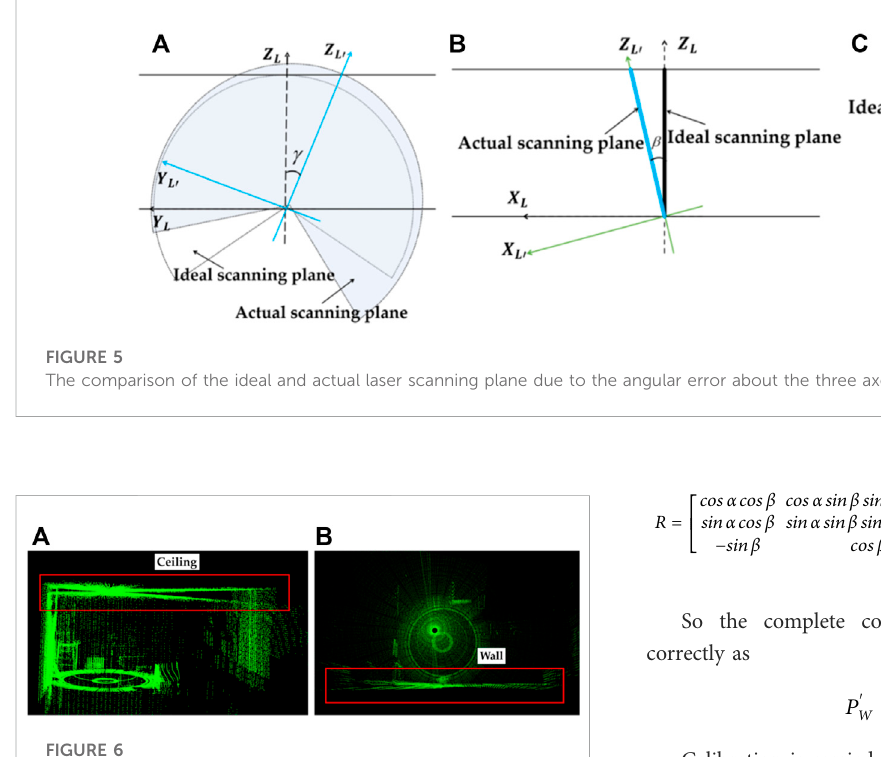
FIGURE 6 Original scan captured by our system without calibration, visible distortion is marked in red box (A) distortion in ceiling (B) distortion in